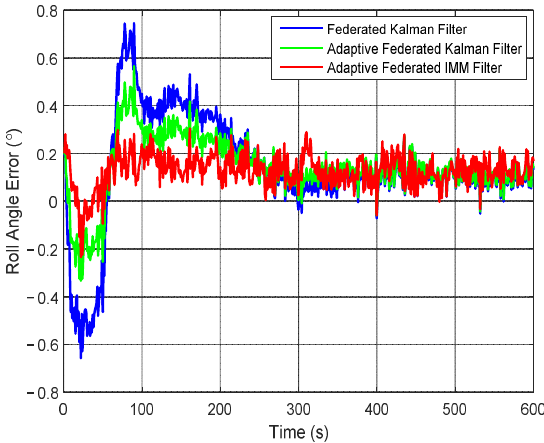
Figure 12. The estimation curves of roll angle error.